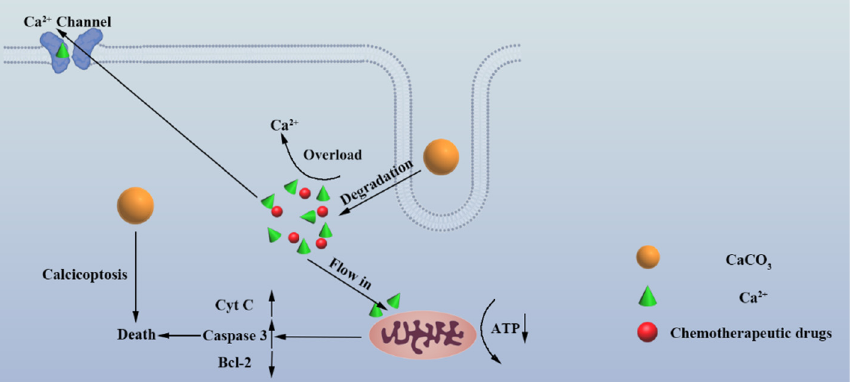
Figure 4. Schematic illustration of calcium overload-induced calcicoptosis. The overload of calcium ions in cancer cells promotes the damage of mitochondria, which induces specific calcium overload- induced cell death, which is called “calcicoptosis”.